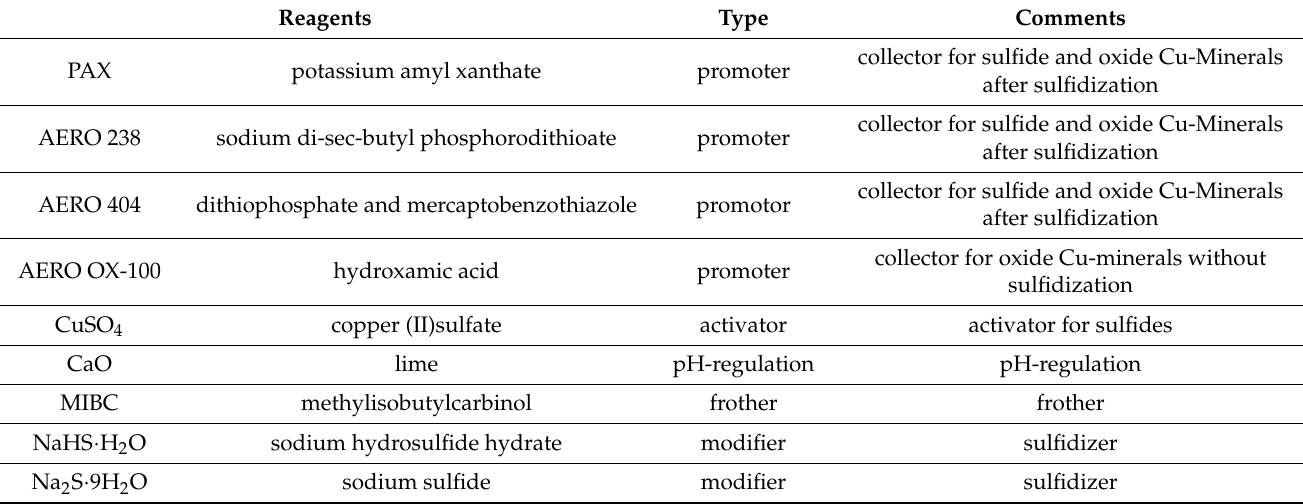
Table 1. Reagents used for flotation